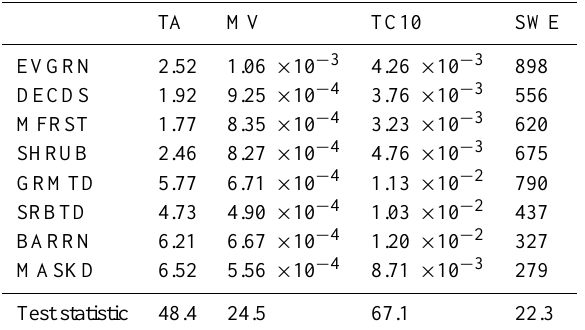
Table 2. Results from Levene’s test examining homogeneity of vari- ances of all variables within seven vegetation classes (Table 1), and a class containing permanent snow and ice which is masked from analysis (MASKD). These variables are air temperature (TA), volu- metric soil moisture (MV), vegetation transmissivity at 10.7GHz (TC10), and snow water equivalent (SWE). All p values are < 10 − 5